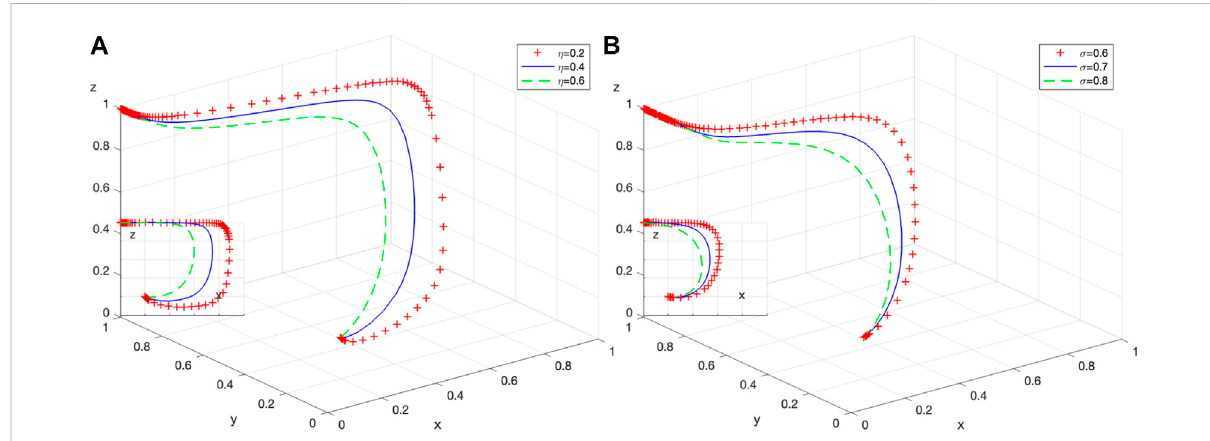
FIGURE 2 (A) Simulation results when η (cid:2) 0 . 2 , 0 . 4 , 0 . 6. Figure 2. (B) Simulation results when σ (cid:2) 0 . 6 , 0 . 7 , 0 .